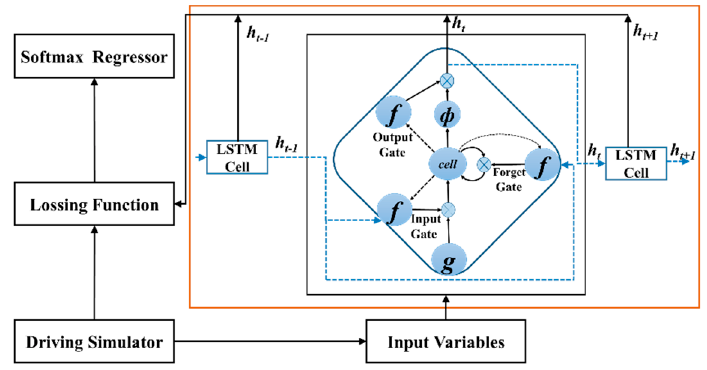
Figure 7. Structure of ϵ ‐ greedy long short term memory (LSTM).